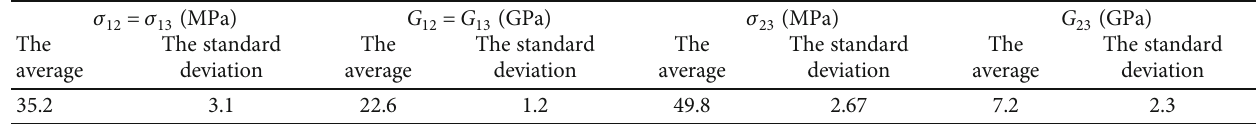
Figure 5: Fiber rod longitudinal shear and transverse shear test fi xture. Table 3: Shear properties of fi ber rod.